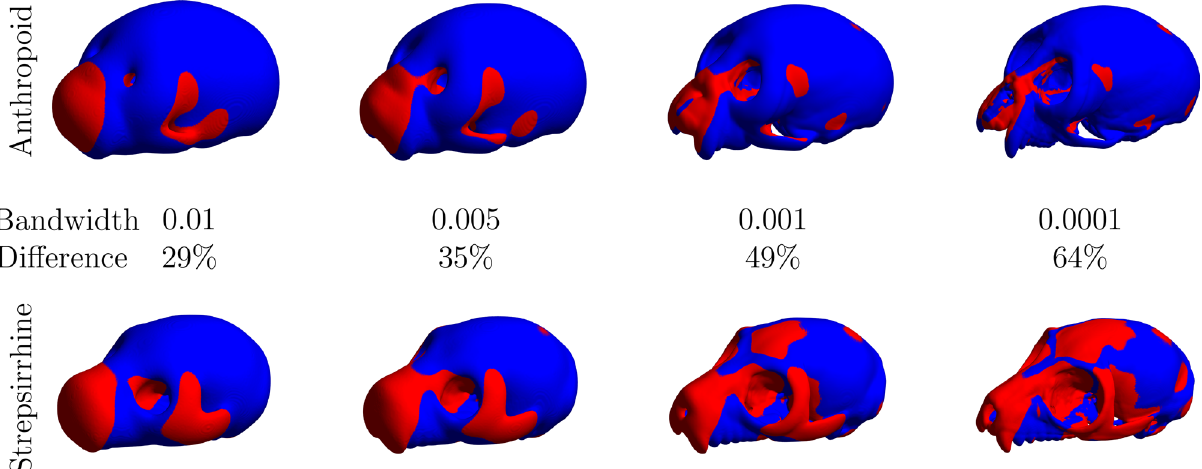
Figure 2. Skull shape characterization by Spherical Wave Decomposition (SWD) on skulls of an Anthropoid and a Strepsirrhine from MorphoSource. Bandwidth (i.e. more accurate shape description) increases from left to right. Blue voxels are similar between skulls, red are dissimilar. As fit increases, the percent of voxels in the volume that are different between the species increases.